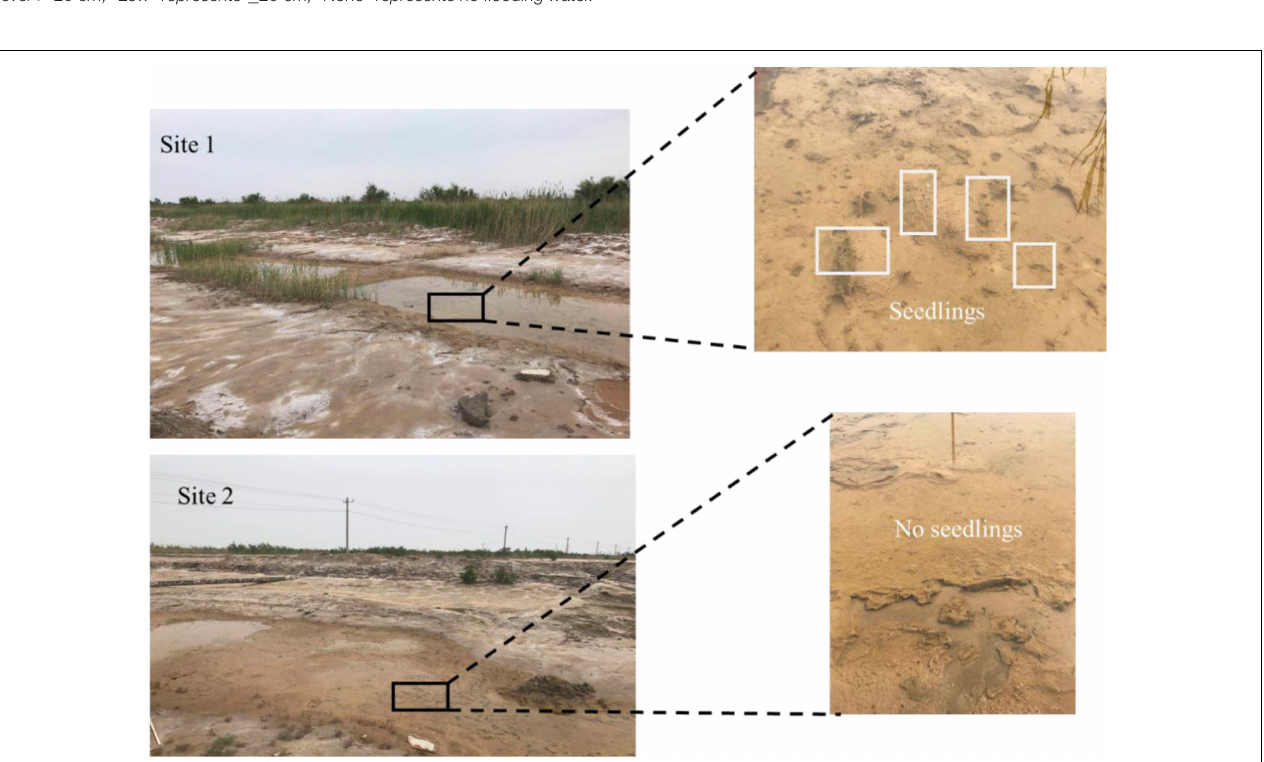
FIGURE 2 | Ruppia sinensis growth status in May 2018.